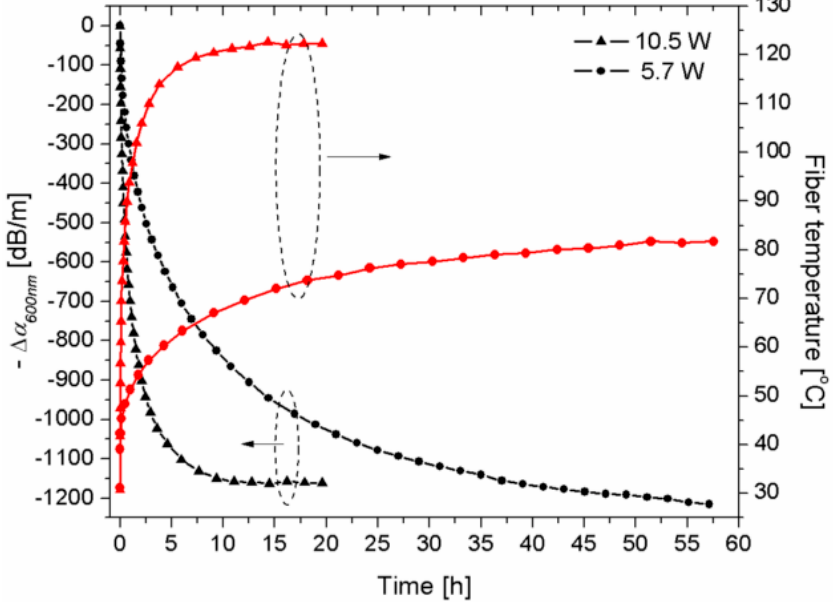
Figure 7. PD-induced absorption coefficient change ( ∆ α ) at 600 nm (primary y -axis) and respective fiber temperature (secondary y -axis) measured with a thermal camera. Adapted with permission from [38] © The Optical Society.